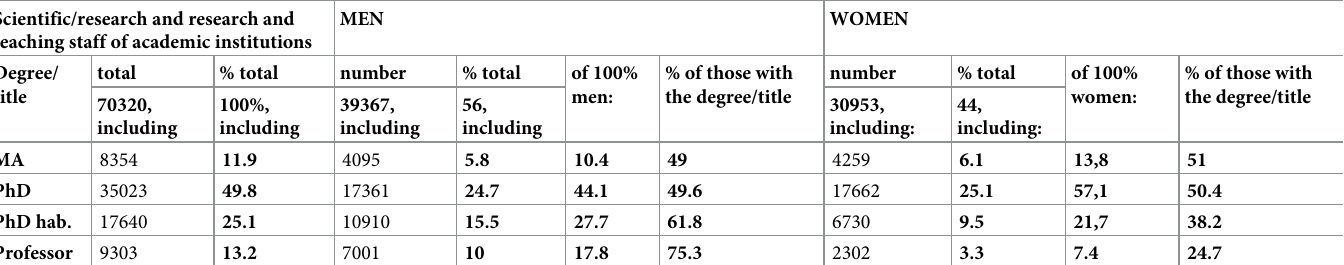
Table 1. Table scientific/research and research/research and teaching staff of academic institutions in Poland. Source: compilation by E. Krause, based on the data provided to the author by OPI PIB (as of 29.01.2018). Scientific/research and research and teaching staff of academic